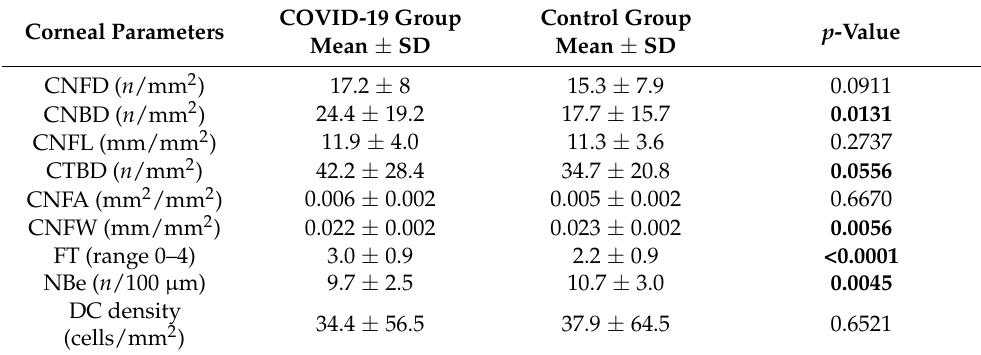
Table 2. Corneal confocal microscopy data in COVID-19 and control groups. Corneal